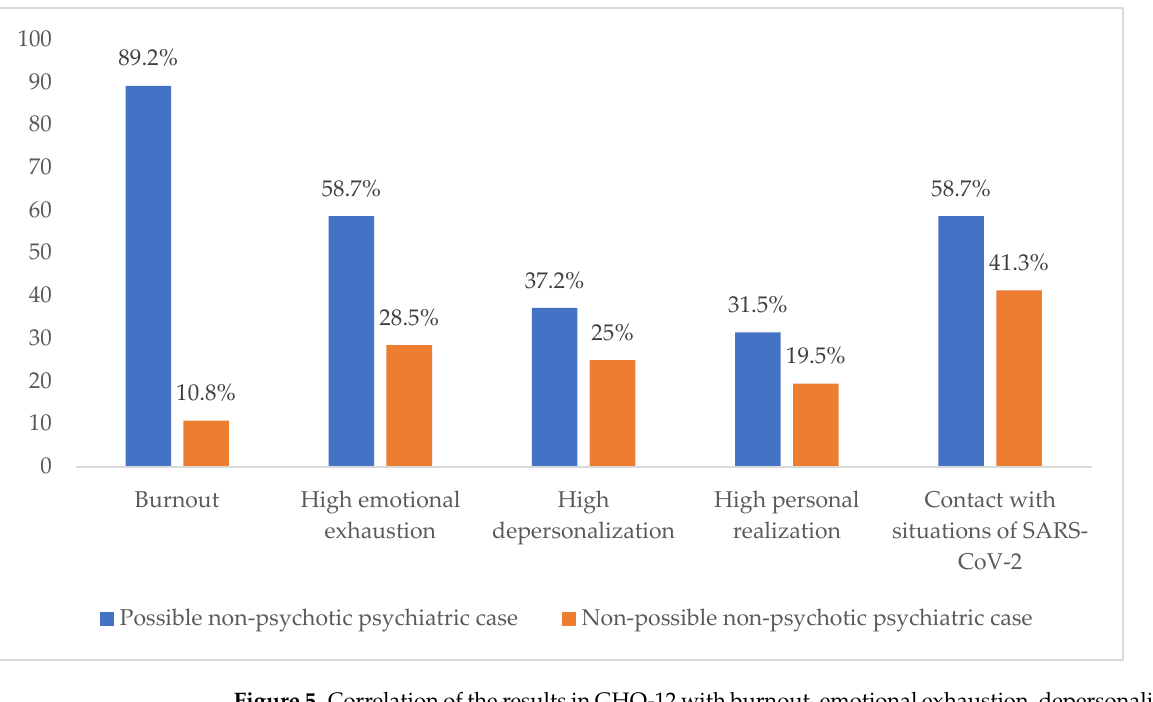
Figure 5. Correlation of the results in GHQ-12 with burnout, emotional exhaustion, depersonalization, personal realization and contact with situations of SARS-CoV-2.